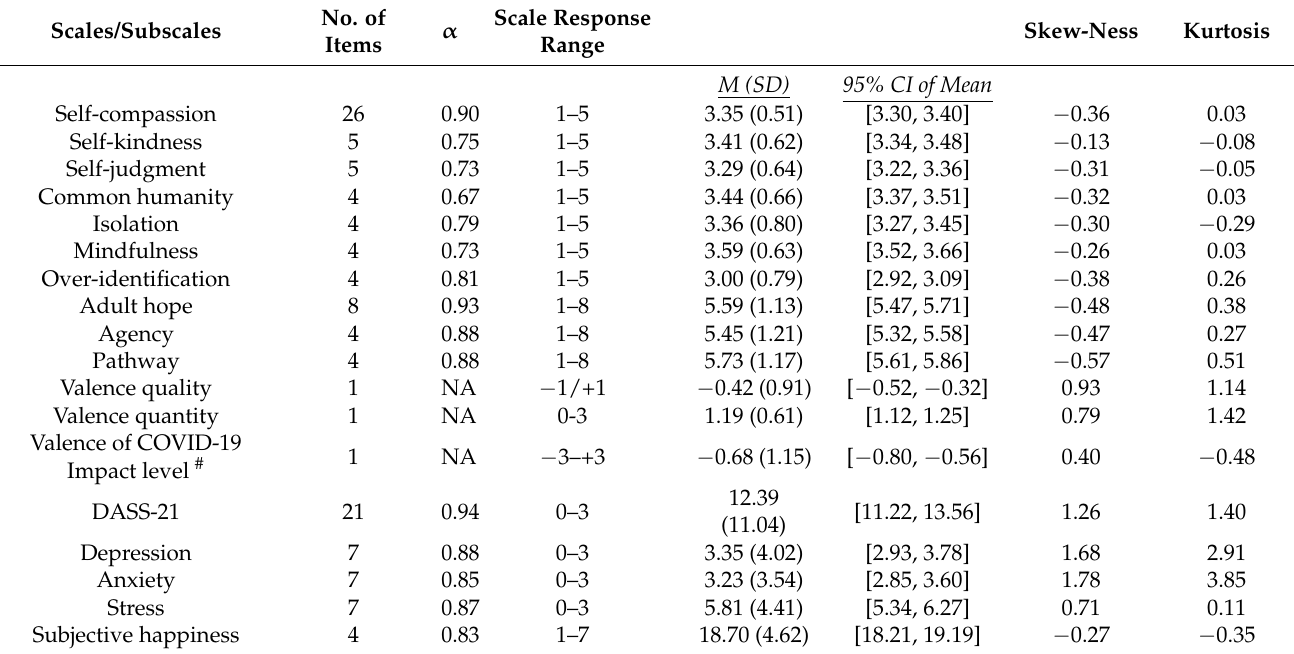
Table 1. Descriptive statistics of study variables ( N = 345).